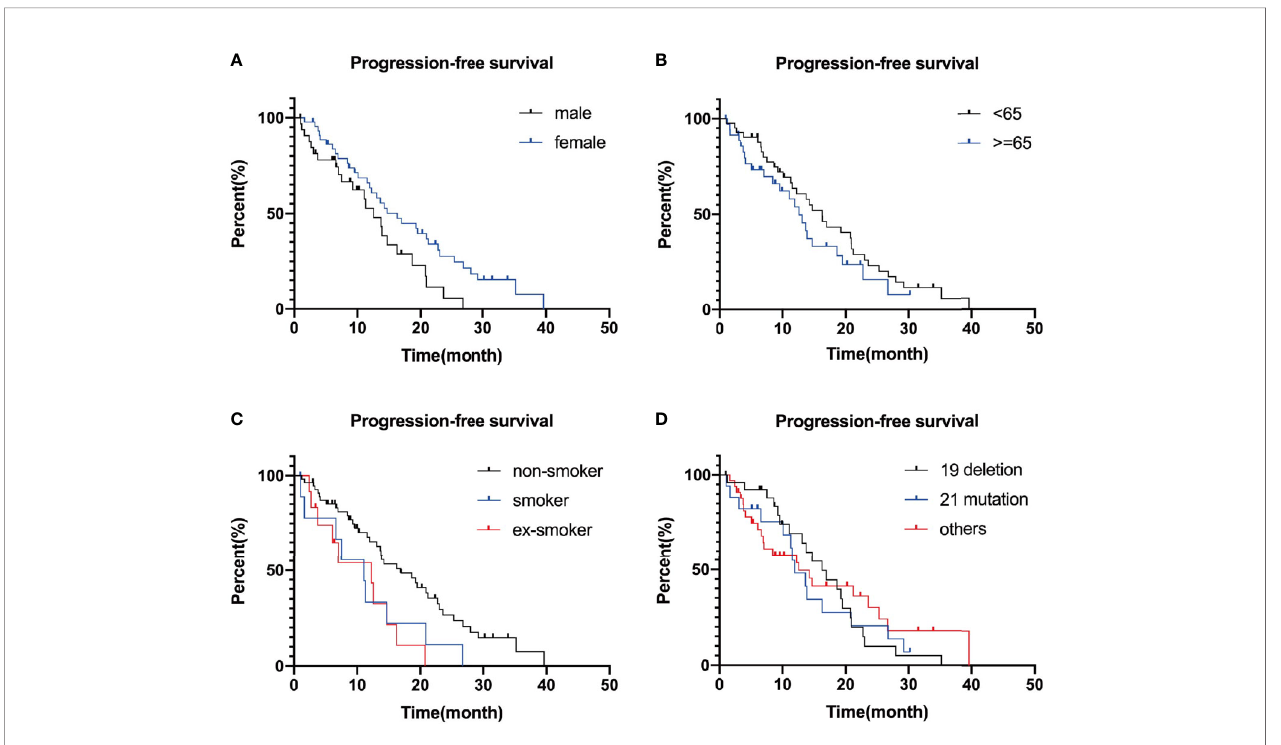
FIGURE 3 | Survival curves plotted separately by gender (A) , age (B) , smoking (C) , and genotype group (D) . P-values are 0.124, 0.168, 0.929, and 0.094,